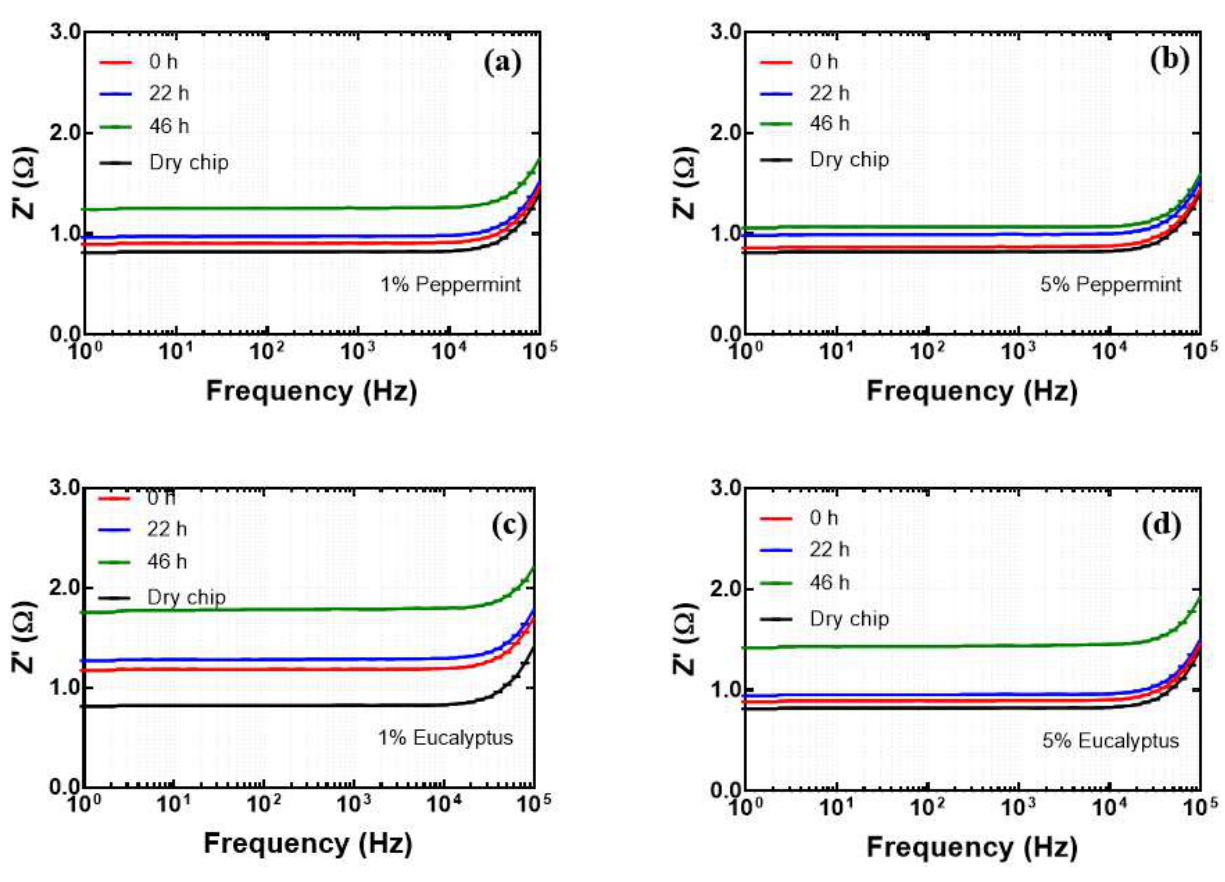
Figure 4. Electrical resistance of Au-based microfluidic chip as a function of frequency at different time intervals under the influence of ( a ) 1% peppermint, ( b ) 5% peppermint, ( c ) 1% eucalyptus, ( d ) 5% eucalyptus essential oils.